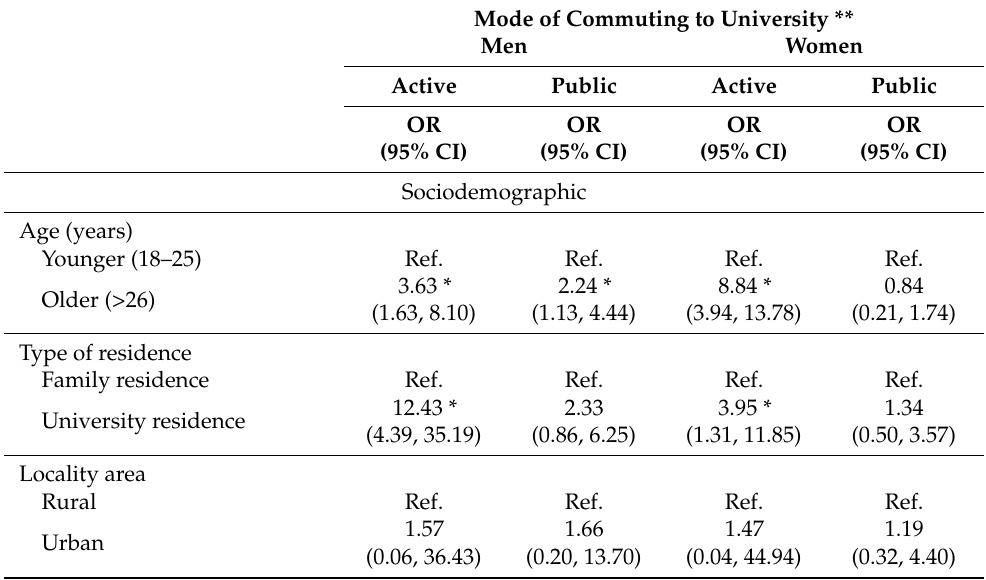
Table 2. Associations between mode of commuting with sociodemographic characteristics and commuting behaviors measures in university students by